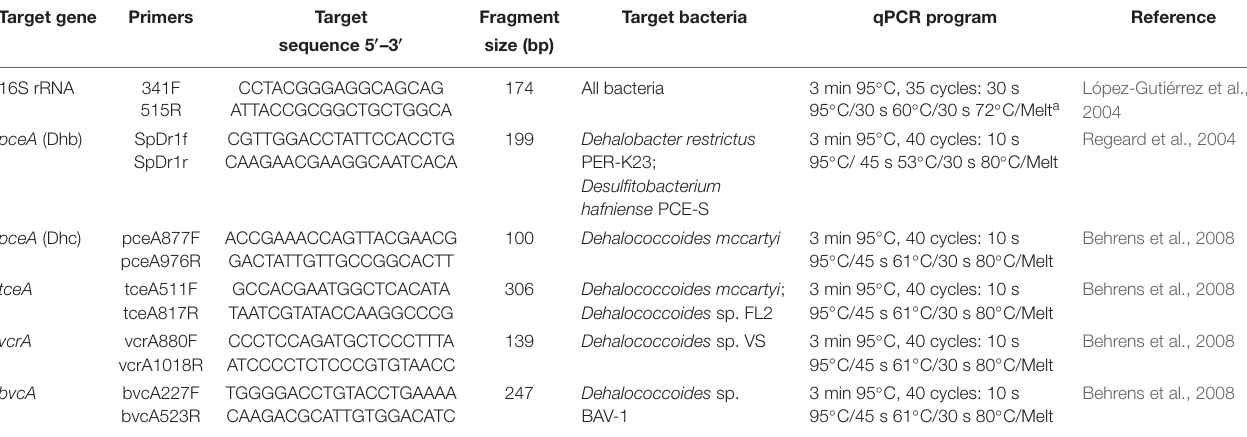
TABLE 2 | qPCR primers and temperature programs used in this study. Target gene Primers Target Fragment Target